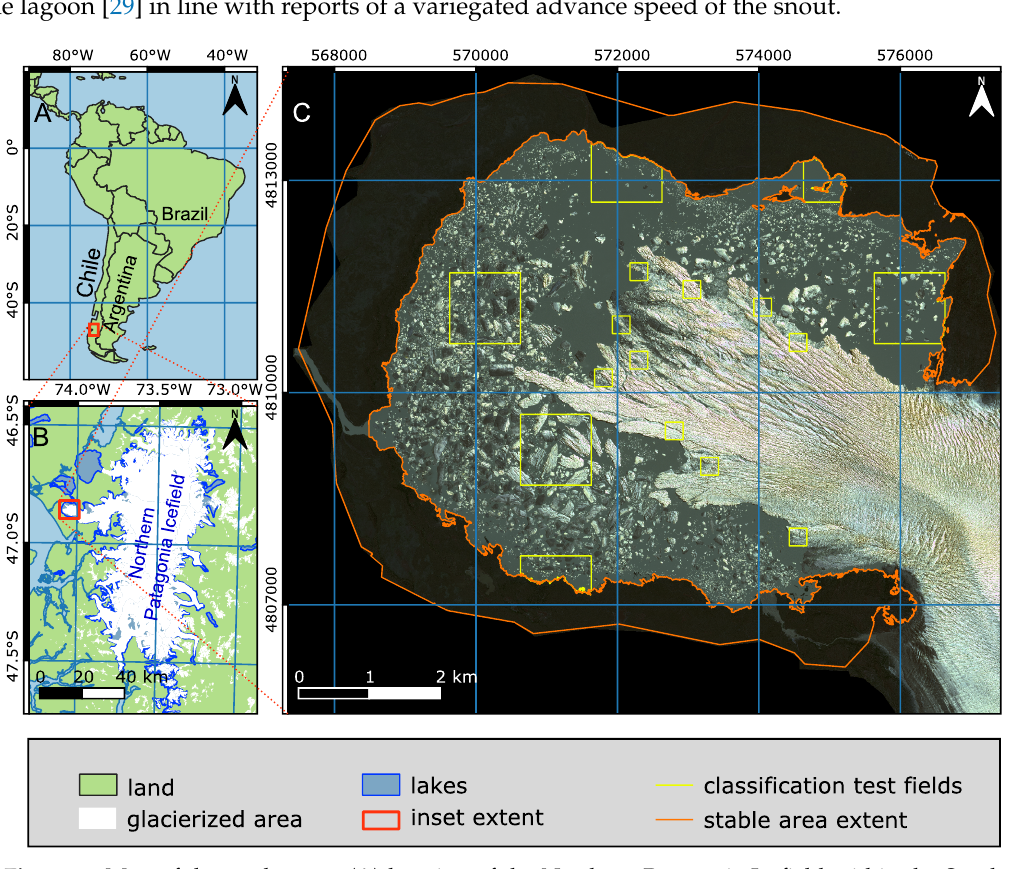
Figure 1. Map of the study area: ( A ) location of the Northern Patagonia Icefield within the South America; ( B ) location of the San Quintín terminus and lagoon in the region; and ( C ) WV-2 image of the study area. Coordinates of ( C ) in UTM 18S coordinate